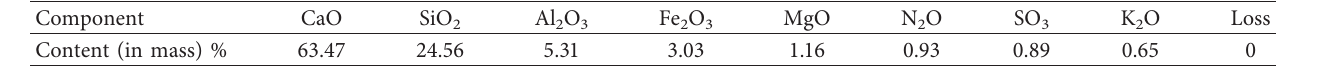
Table 2: Chemical composition of Portland cement PO 42.5.